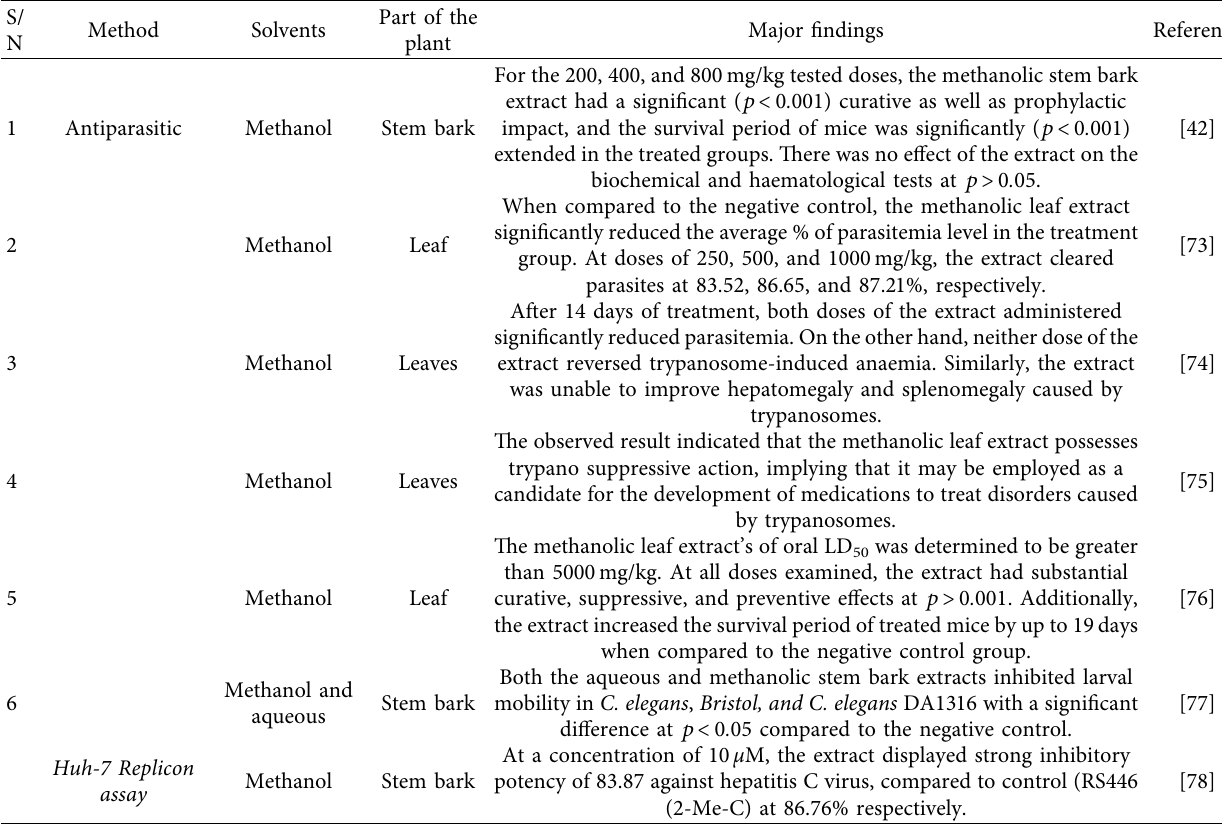
Table 6: Antiparasitic activity of D. microcarpum